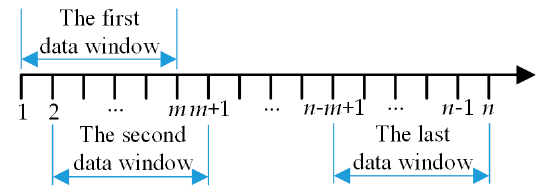
Figure 6. The schematic segment curve fitting.